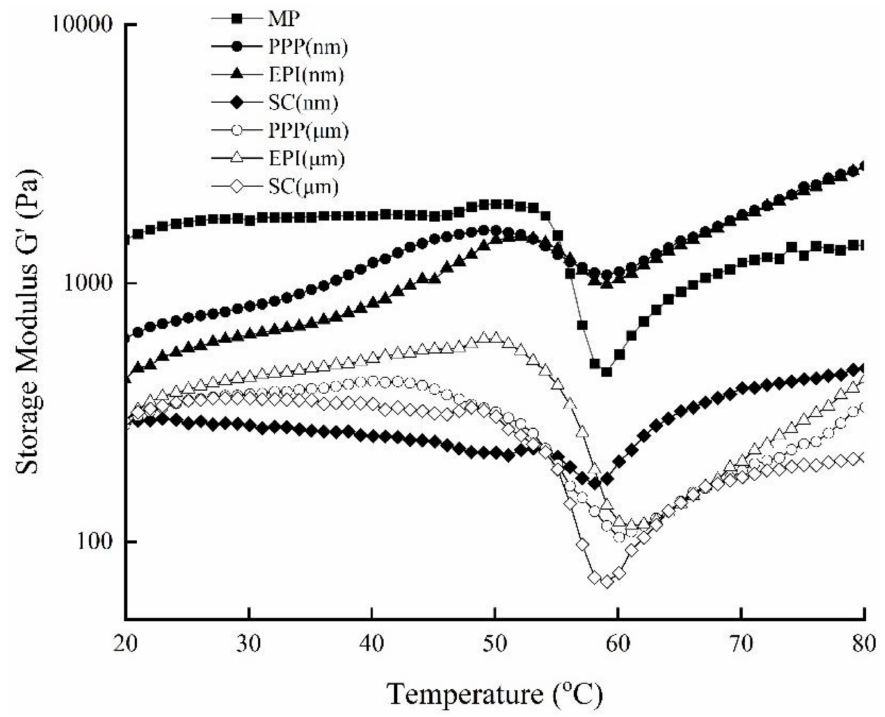
Figure 4. Heat scanning rheological dynamic storage modulus (G (cid:48) ) of MP-emulsified soybean oil composite sols. PPP: porcine plasma protein; EPI: egg-white protein isolate; SC: sodium caseinate; MP: myofibrillar